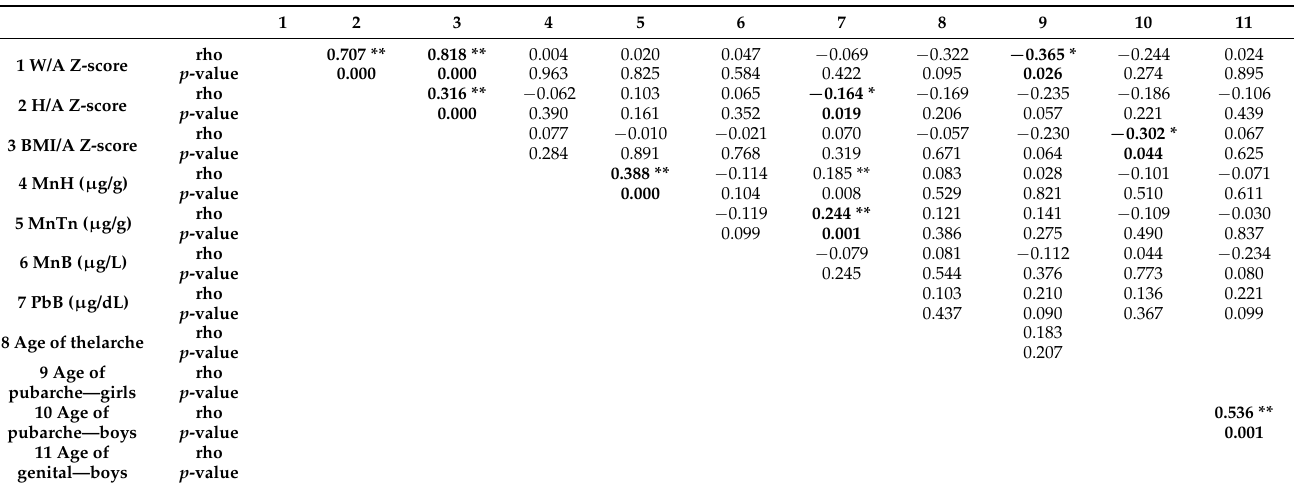
Table 3. Spearman correlation coefficients among anthropometric parameters, exposure biomarkers and onset age of Tanner’s characteristics for girls and